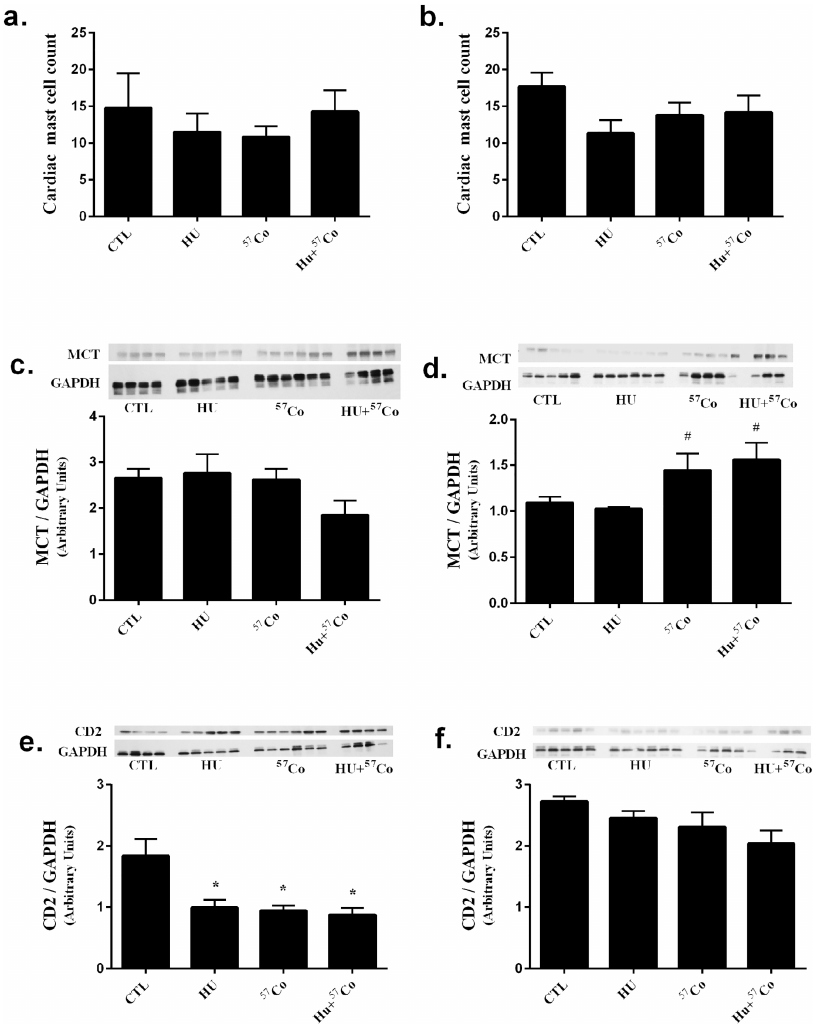
Fig 4. Mast cells and T-lymphocyte markers in mouse heart following HU, γ irradiation or combined HU + γ irradiation. ToluidineBlue histological stainingfor mast cell numbersa.) 4 months and b.) 9 months after HU, γ -irradiation ( 57 Co: 0.01 cGy/h; 0.04 Gy total) or combinedHU + γ -irradiation. Histologysample sizes: CTL for 4 month time-point, n = 4; CTL for 9 month time-point, n = 6; HU for both time-points, n = 6; 57 Co for 4 month time-point, n = 6; 57 Co 9 month time-point, n = 5; HU+ 57 Co for 4 month time-point, n = 4; HU + 57 Co for month time-point,n = 5. Immunoblot analysisof mast cell tryptase (MCT) c.) 4 months or d.) 9 months after exposure. n = 3–6. Immunoblot analysisof CD-2 protein content e.) 4 months and f.) 9 months after treatment. Immunoblot sample sizes: CTL for 4 month time-point n = 4; CTL for 9 month time-point n = 5; HU for 4 month time-point n = 5, HU for 9 month time-point n = 6; 57 Co for 4 month time-point n = 6; 57 Co for 9 month time-pointn = 5; HU+ 57 Co for 4 month time-point n = 4, HU+ 57 Co for 9 month time-point n = 3. All proteinsare normalized to GAPDH. All values are means ± SEM. * Significantlydifferent than CTL, p < 0.05; # Significantly different than HU, p < 0.05.